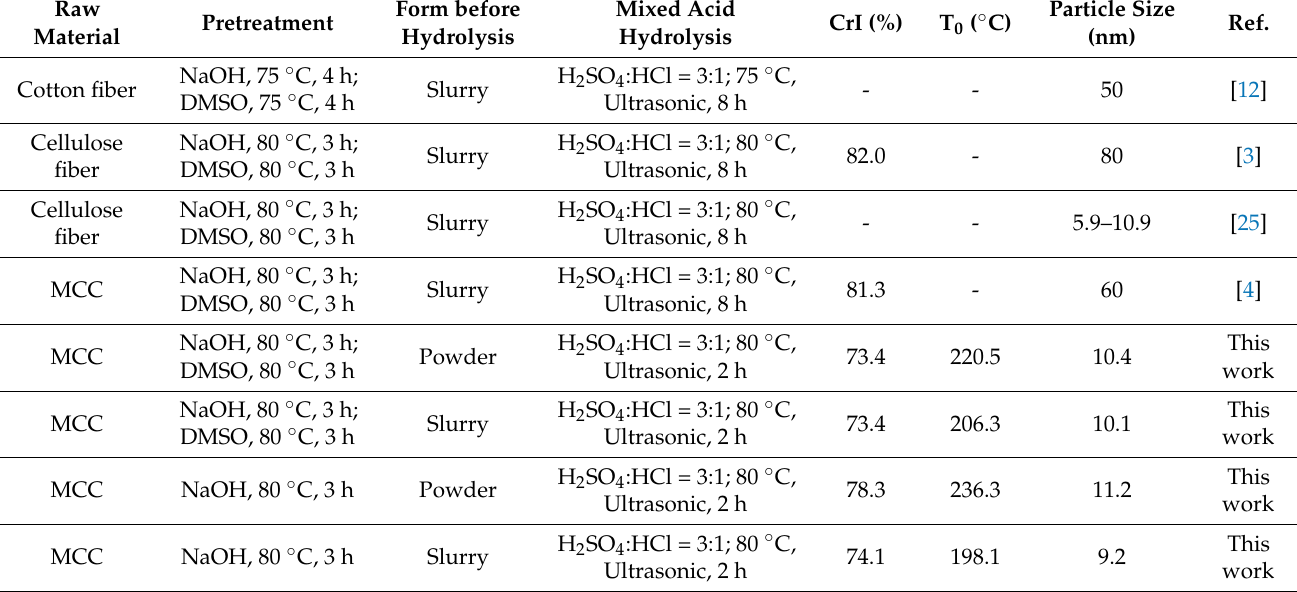
Table 3. Spherical CNC (cellulose II) prepared by mixed acid hydrolysis with different